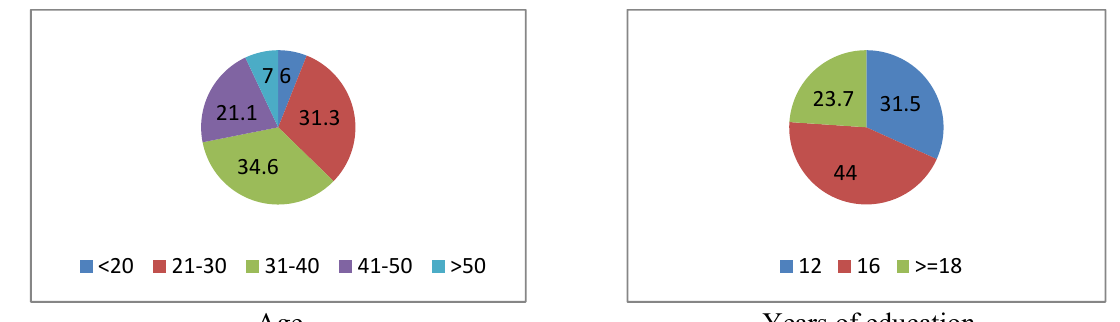
Fig. 2. Personal characteristics of the participants